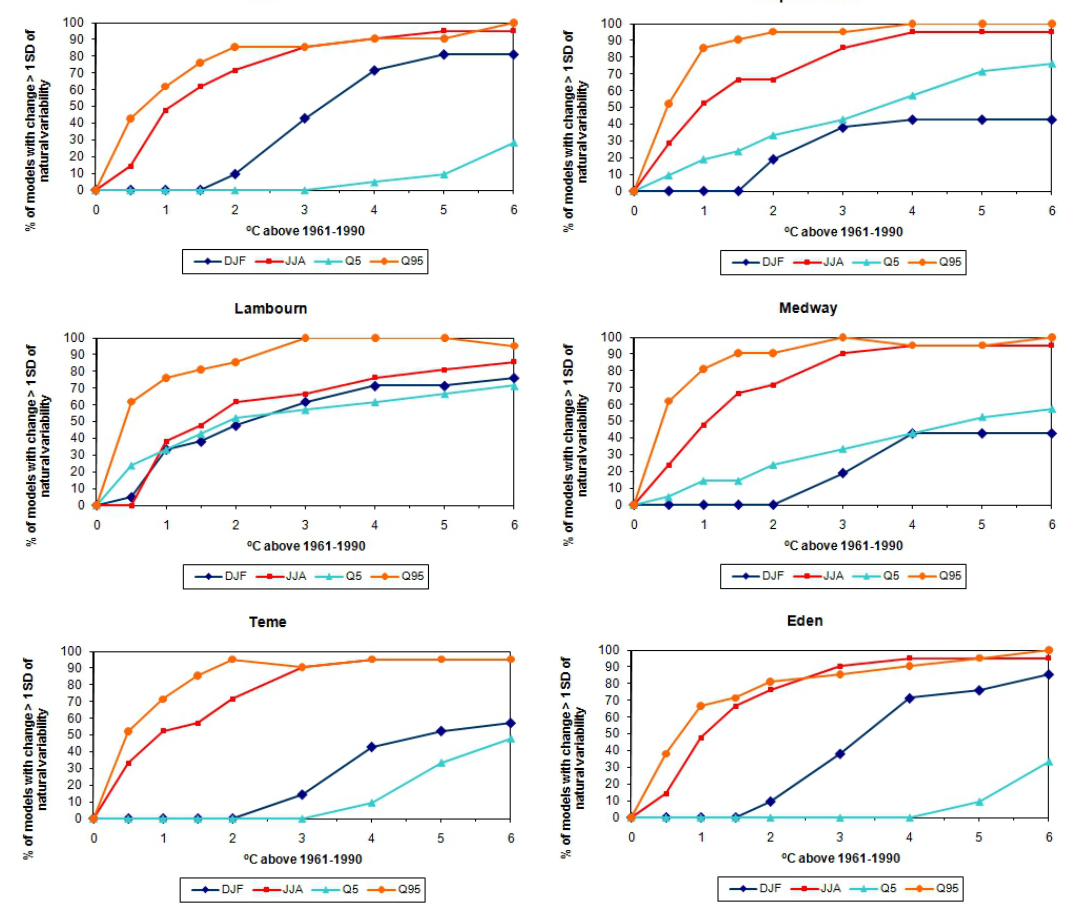
Fig. 7. Proportion of climate scenarios where change in runoff indicators exceeds the standard deviation due to climatic